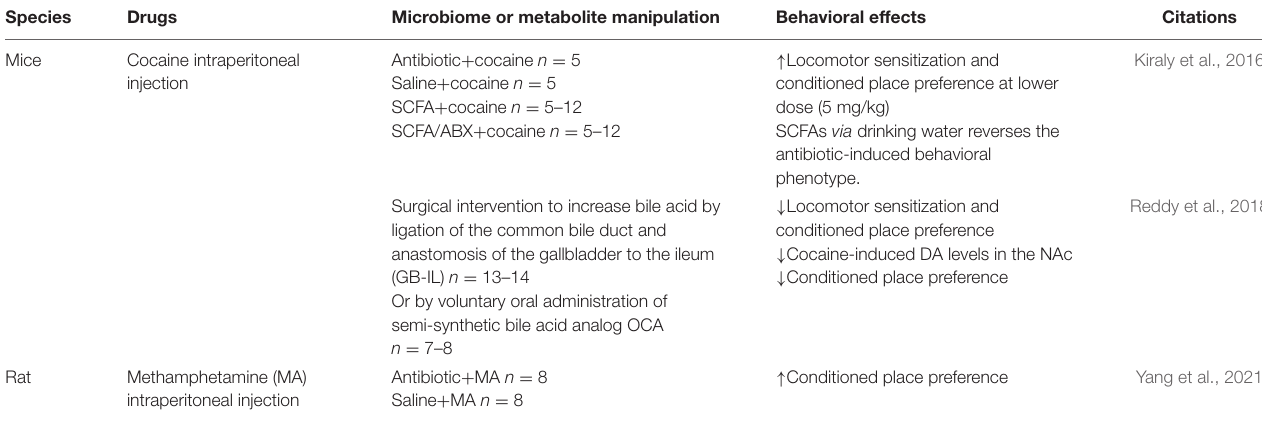
TABLE 7 | Interventions altering gut microbiome in psychostimulant-related disorders. Species